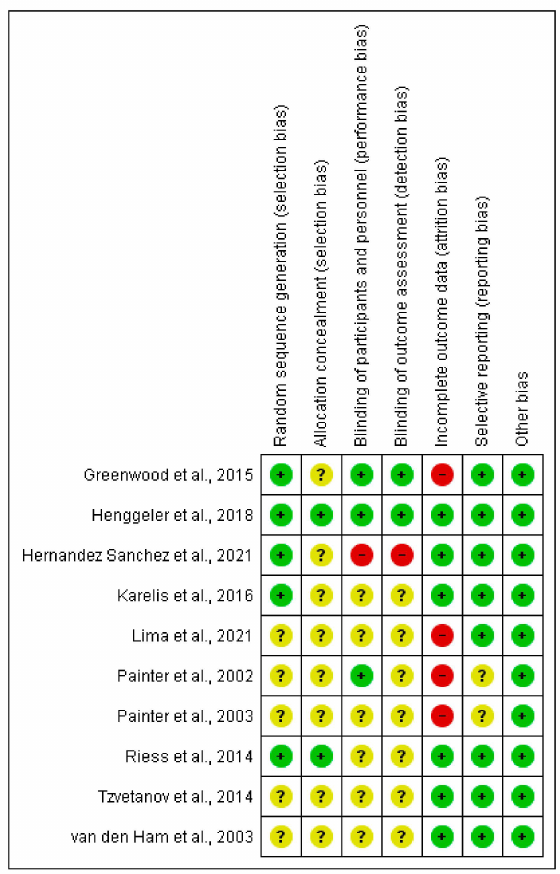
Figure A3. Transplant trials [69–78].